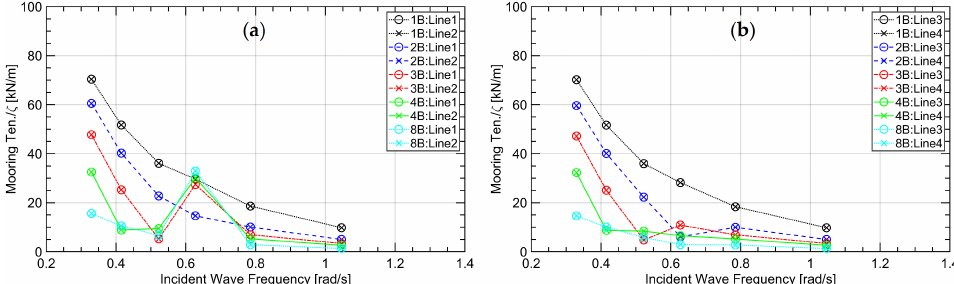
Figure 10. First-order mooring tension amplitudes of the five test cases for the chain configuration, where n B denotes the configuration with n bodies; subscript n , the corresponding n -th mooring line: ( a ) line 1 and line 2; ( b ) line 3 and line